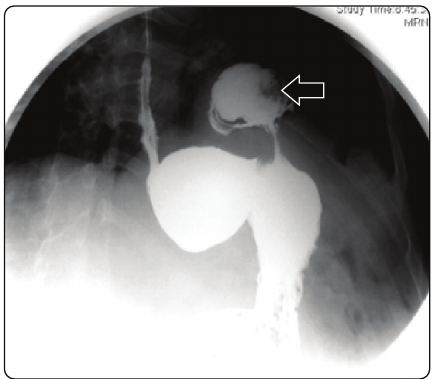
Figure 1: Oesophagogastroduodenal transit (arrow points at gastric content into the thorax).